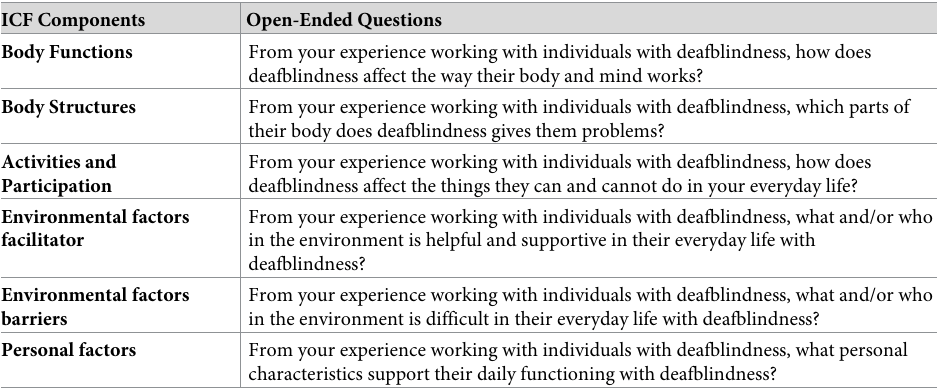
Table 3. Expert study